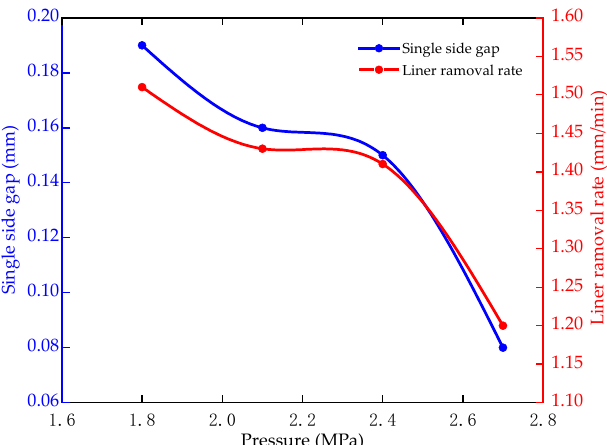
Figure 17. Single side gap and linear removal rates with different duty ratios.